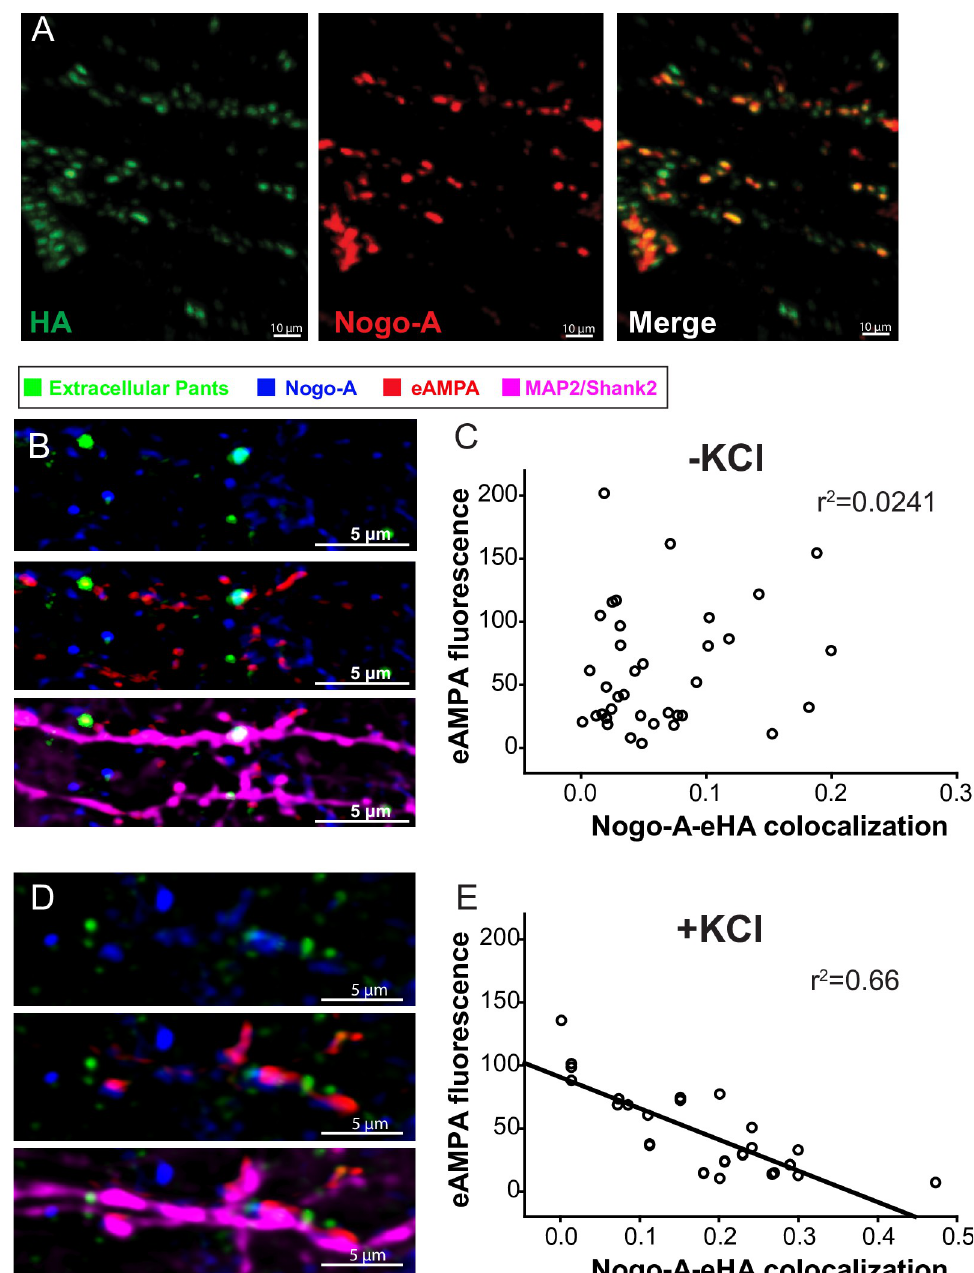
Fig 6. Pants interacts with Rtn4/Nogo in vitro and in vivo. A) Immunocytochemical co-localization of Pants and Nogo-A in cultured Pants SOG-Y hippocampal neurons B) AMPA receptor clustering at synapses where Pants colocalizes with Nogo-A versus Pants-free synapses in the absence of stimulation. C) Correlation between Pants-Nogo-A co- localization and GluR1 AMPA receptor fluorescence in the membrane of spine ROIs in the absence of stimulation. D ) AMPA receptor clustering at synapses where Pants colocalizes with Nogo-A versus Pants-free synapses immediately after KCl stimulation. E ) Correlation between Pants-Nogo-A co-localization and GluR1 AMPA receptor fluorescence in the membrane of spine ROIs immediately after KCl stimulation. n = 3 samples, 40 ROIs each.